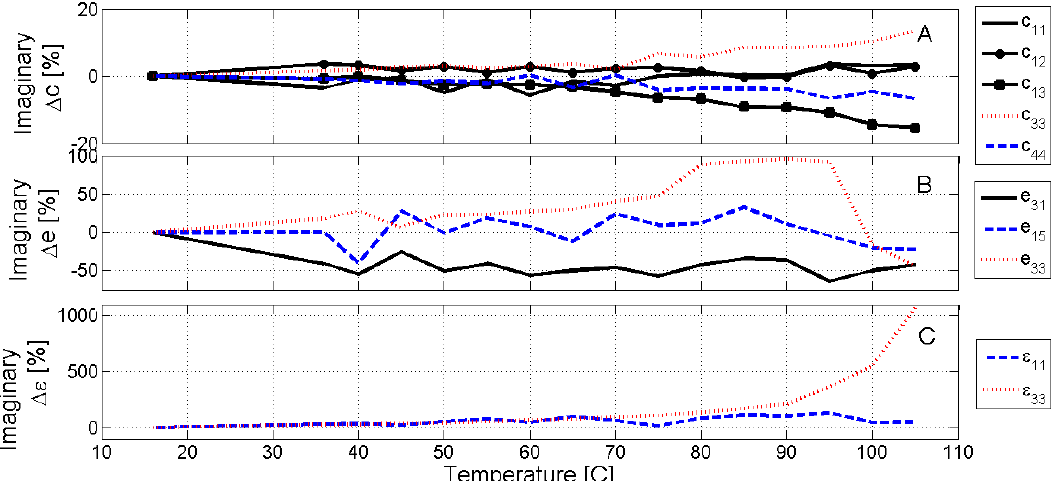
Figure 7. Thermal evolution of the imaginary part of the elastic, dielectric, and piezoelectric parameters. Parameters related with the thickness mode (high sensitivity) are represented in red. Those related with the radial modes are represented in black, and those related with the complex resonances C 1 and C 2 in blue.